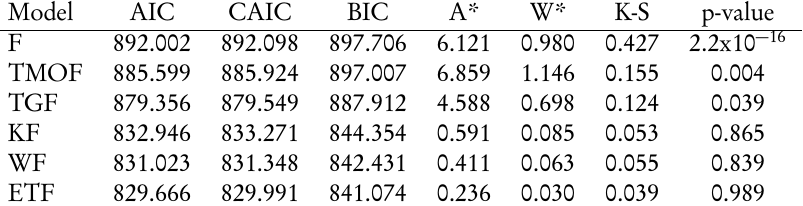
Goodness of fit